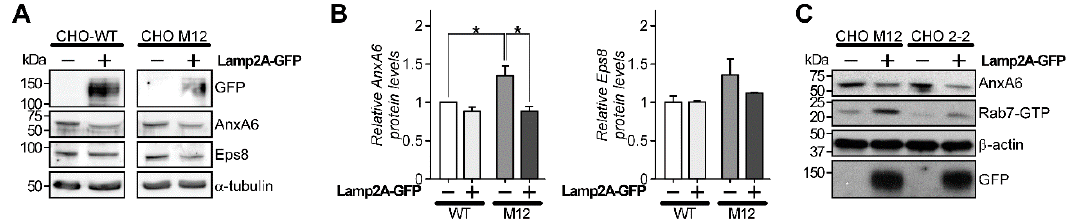
Figure 3. Overexpression of Lamp2A increases AnxA6 protein degradation. ( A ) Cell lysates from CHO-WT and CHO M12 cells ± ectopically expressed Lamp2A-GFP as indicated were analyzed by Western blotting for GFP, AnxA6, Eps8, and α -tubulin. A representative western blot from two independent experiments is shown. ( B ) The intensity of AnxA6 and Eps8 bands was quantified and normalized to α -tubulin. Data shown represents the mean ± SEM (* p < 0.05). ( C ) CHO M12 and CHO 2-2 cells were transfected ± Lamp2A-GFP as above. Cell lysates were prepared and subjected to Rab interacting lysosomal protein (RILP)-C33–GST pull-down assays to determine active Rab7 (Rab7-GTP) levels (see Material and Methods for details). Total levels of AnxA6, β -actin, and GFP in cell lysates are shown.